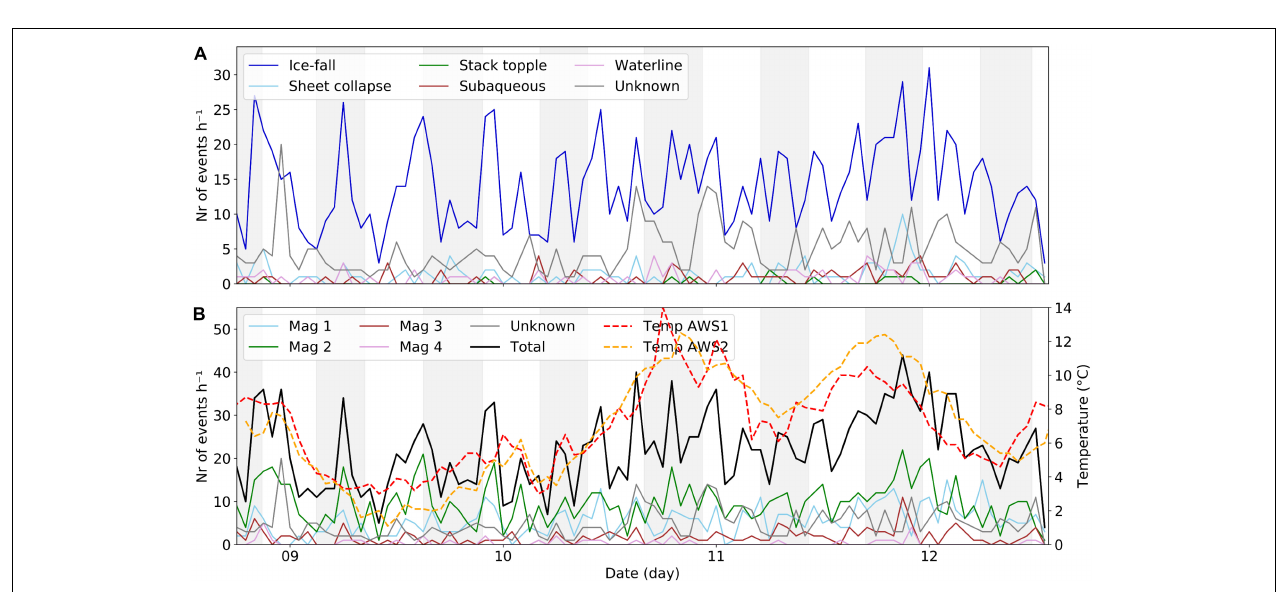
FIGURE 5 | An example of the calving event type “stack topple” detected in the sTLC images on 8 July 2018. The image sequence shows the example over time from 0 s (A) to 10 s (B) 20 s (C) and 30 s (D) . Examples of the other calving event types are shown in Supplementary Figure 3 .